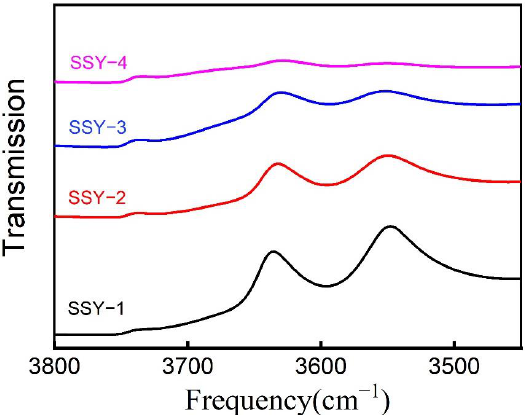
Figure 4. IR spectra of the ammonium hexafluorosilicate modified zeolites hydroxy groups.